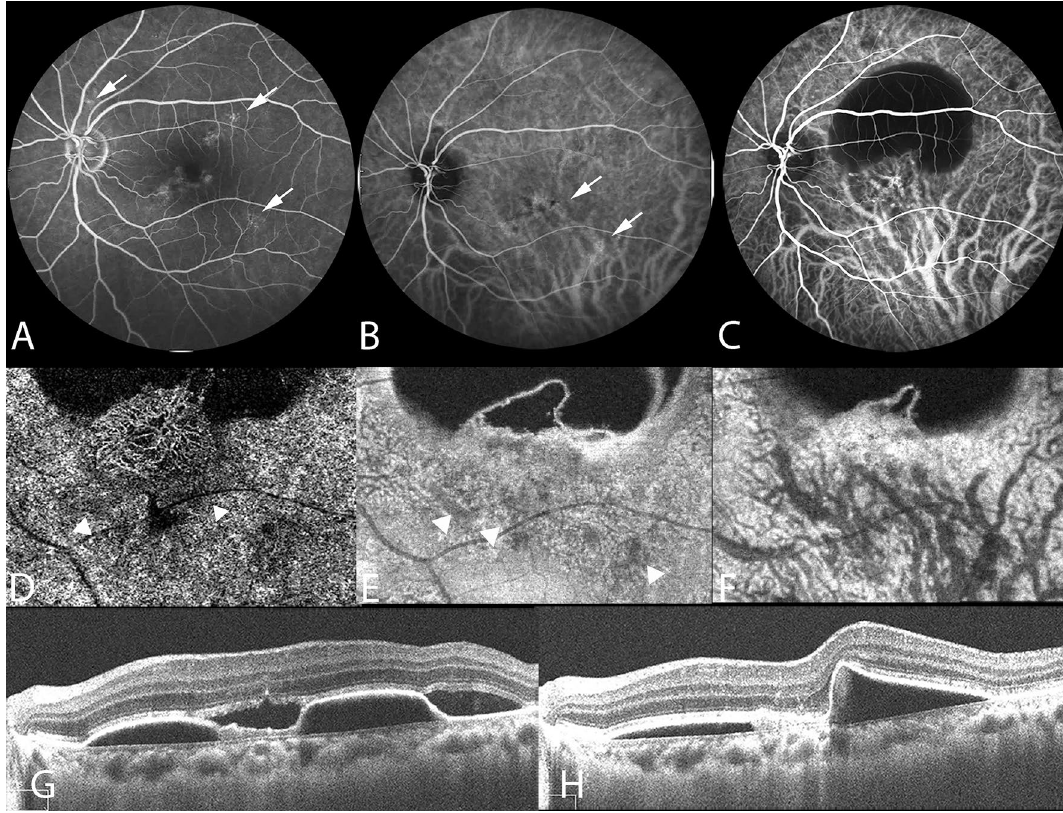
Figure 2. Multimodal imaging of the left eye of a 38-year-old woman with chronic central serous chorioretinopathy and subsequent polypoidal choroidal vasculopathy. ( A ) Fluorescein angiography revealing focal leakage points (white arrows). ( B ) Multifocal hyperfluorescent areas (white arrows) shown on the indocyanine green angiography (ICGA) in the middle phase. Pachyvessels can be seen in the inferotemporal quadrant; they do not taper toward the posterior pole and terminate abruptly. ( C–H ) Polypoidal choroidal vasculopathy developed subsequently at the 10-year follow-up. ( C ) ICGA revealing a branching vascular network with terminal aneurysmal dilatations. ( D ) Optical coherence tomography angiography (OCTA) image, with segmentation from 19 to 49 μm with respect to the retinal pigment epithelium (RPE), demonstrating type 1 (sub-RPE) neovascularization overlaying the attenuated choriocapillaris (white arrowheads). ( E ) Focal inward displacement of the underlying pachyvessels (white arrowheads) on OCTA image, with segmentation